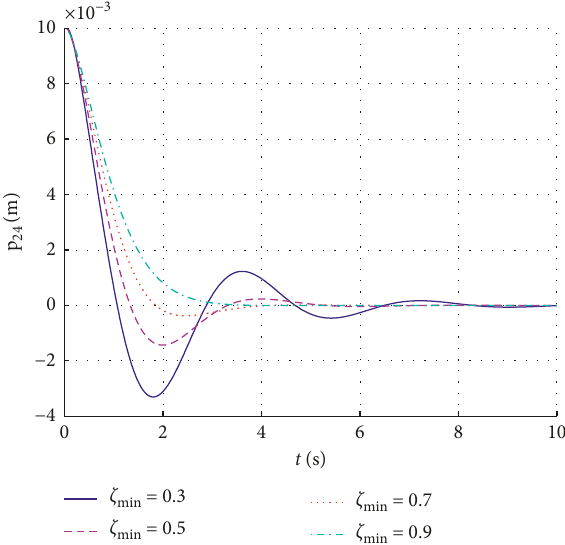
Figure 6: Dominant modes for maximum stability margin approach.